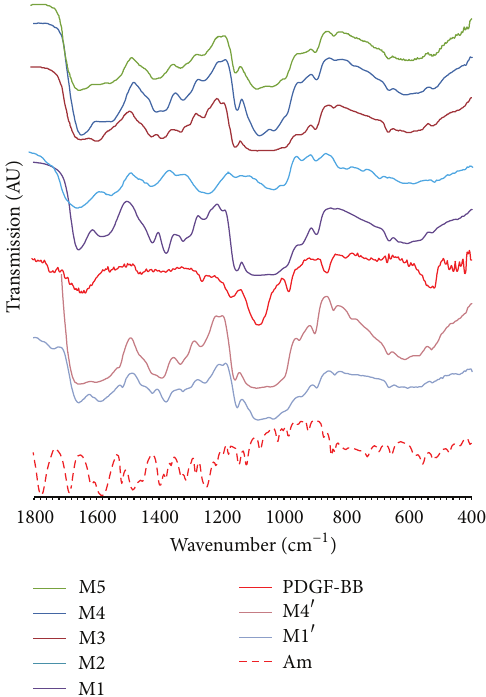
Figure 7: FTIR spectra obtained in thin polymer films of homo- geneous: MCCh, Fb, and composite. MCCh: Fb = 1: 1 membranes with (M1 󸀠 , M4 󸀠 ) and without (M1, M2, and M4) Am. Comparative spectrum for Am was taken in KBr pellets.